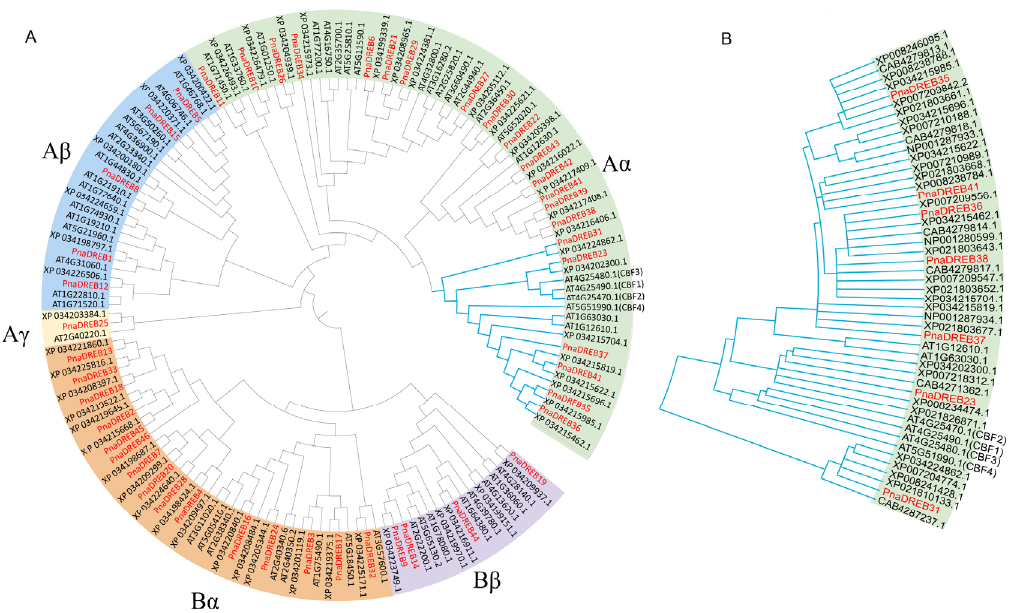
Figure 2. Phylogenetic analysis of the DREB family genes. ( A ) DREB family genes from A. thaliana , wild P. nana , and P. dulcis var. were subjected to a phylogenetic analysis. ( B ) Phylogenetic analysis of homologous CBF genes from A. thaliana , P. nana , P. dulcis cultivar ‘Nonpareil’, P. avium , P. mume , P. persica , and P. armeniaca . MEGA 6.0 was used to generate a maximum likelihood (ML) phylogenetic tree with γ -distributed rates and Jones–Taylor–Thornton. The resultant phylogenetic tree was separated into two large subgroups ( A and B ) and five subgroups are represented with different colors. Red indicates Dreb genes encoded by P. dulcis . The initial letter indicates different species such as XP_021: P. avium ; XP_034: P. dulcis cultivar ‘Nonpareil’; XP_008: P. mume ; XP_007: P. persica ;